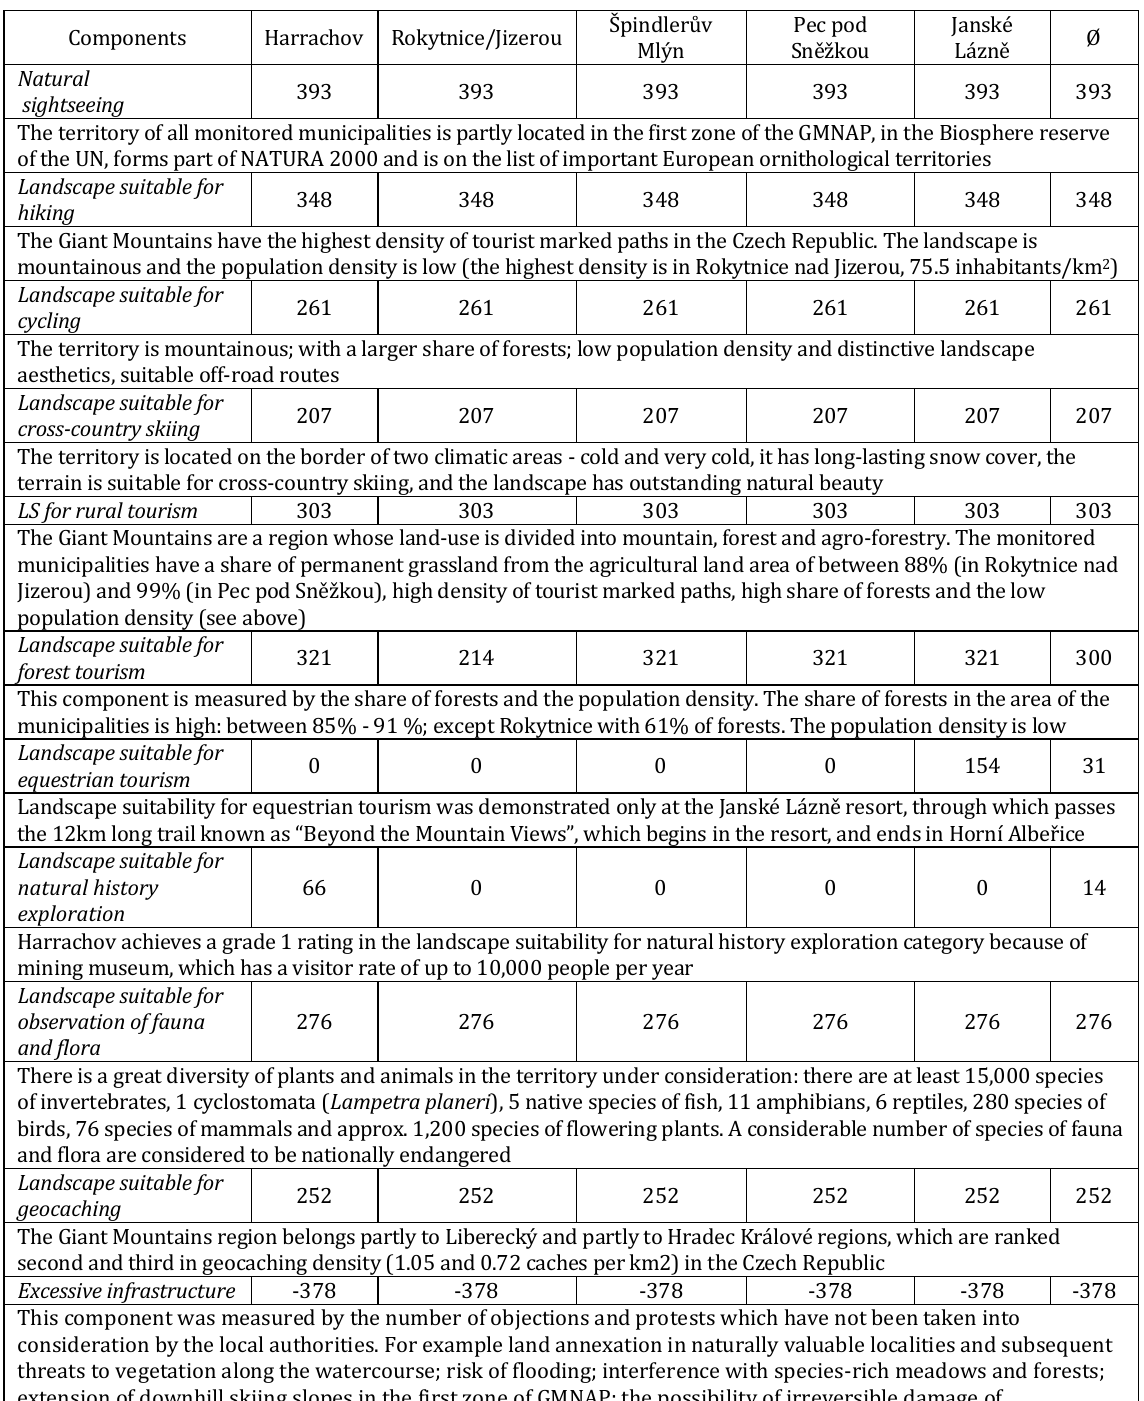
Table 2. Resulting potential of the Giant Mountain region for sustainable tourism (Author’s own